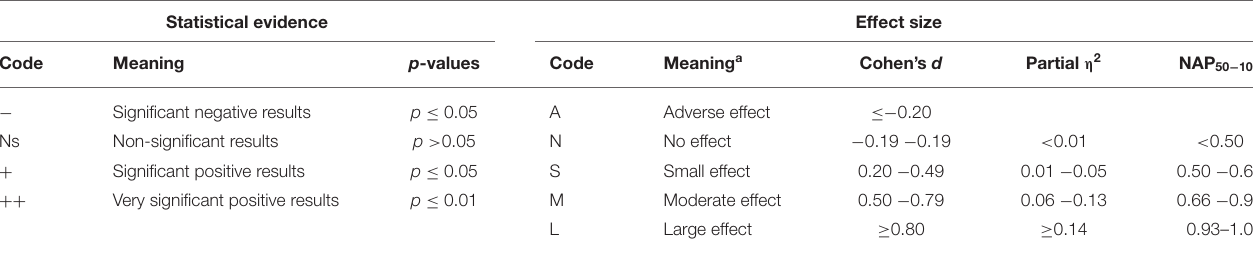
TABLE 2 | Classification statistical evidence and effect